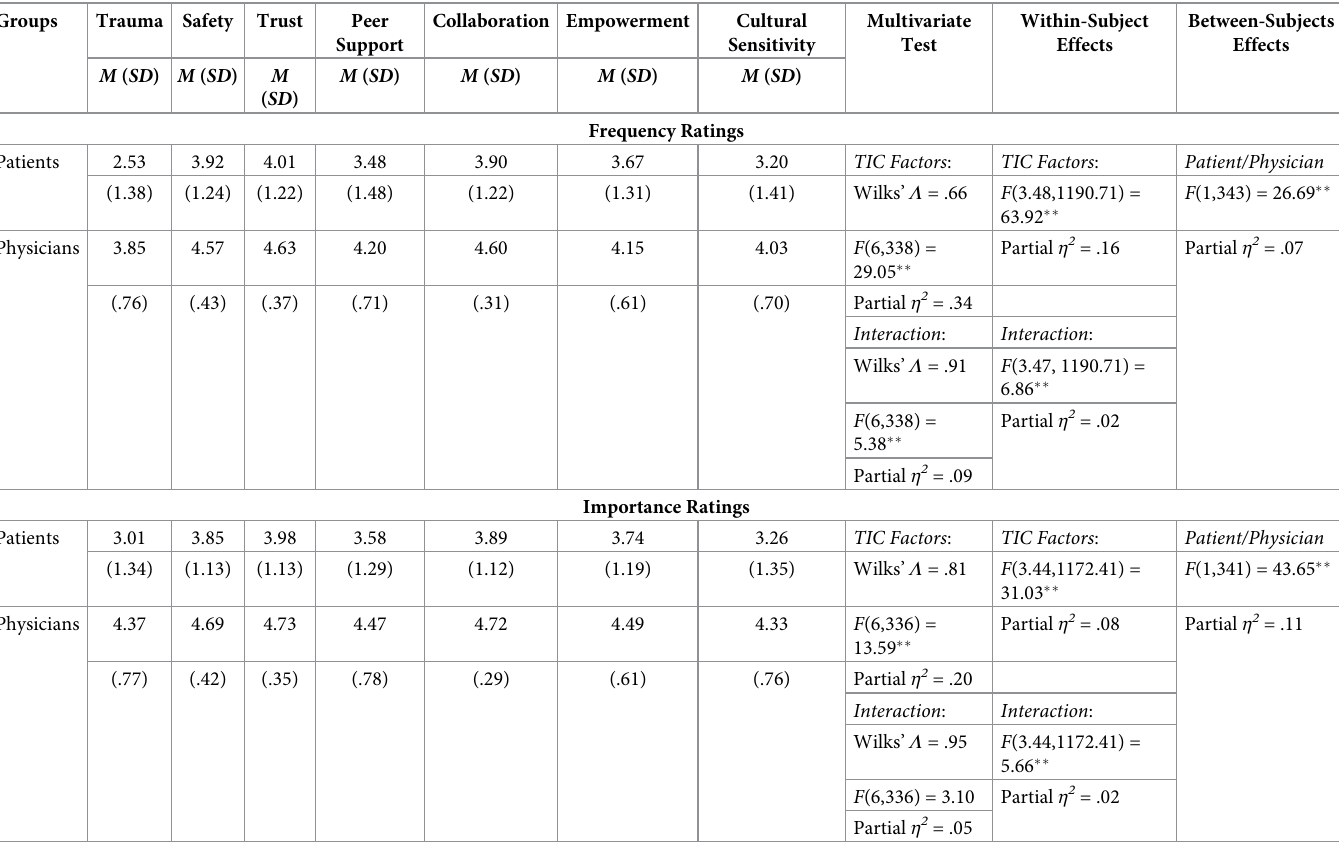
Table 2. Repeated measures ANOVA for patients’ and physicians’ opinion on aspects of trauma-informed care.